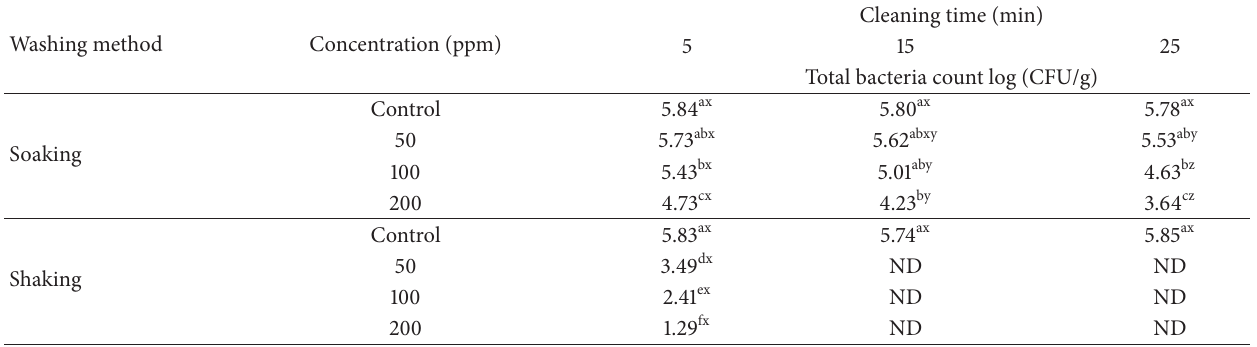
Table 3: Total bacterial counts for tilapia fillets disinfected by soaking or shaking treatments at different chlorine dioxide concentrations. Washing method